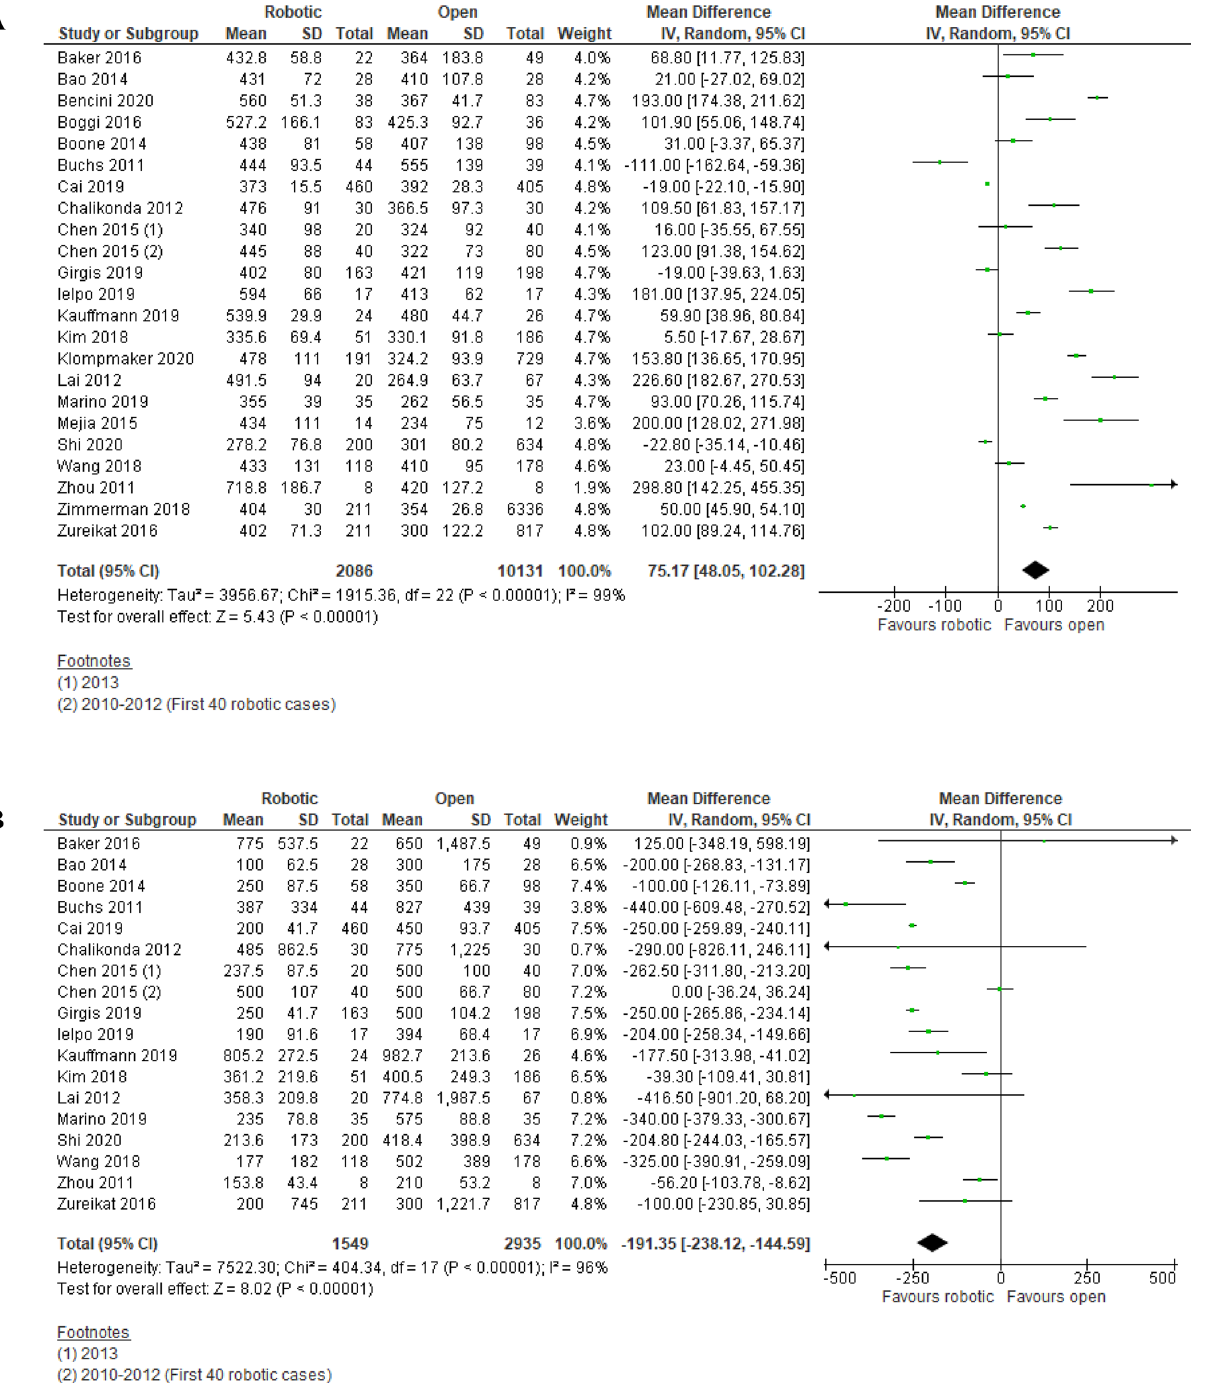
Figure 5. Meta-analysis of secondary endpoints: ( A ) Operating time. ( B ) Estimated blood loss. ( C ) Postoperative pancreatic fistula rate. ( D ) Delayed gastric emptying rate. ( E ) Incisional SSI rate. ( F ) Reoperation rate. ( G ) Length of hospital stay. ( H ) Number of lymph nodes